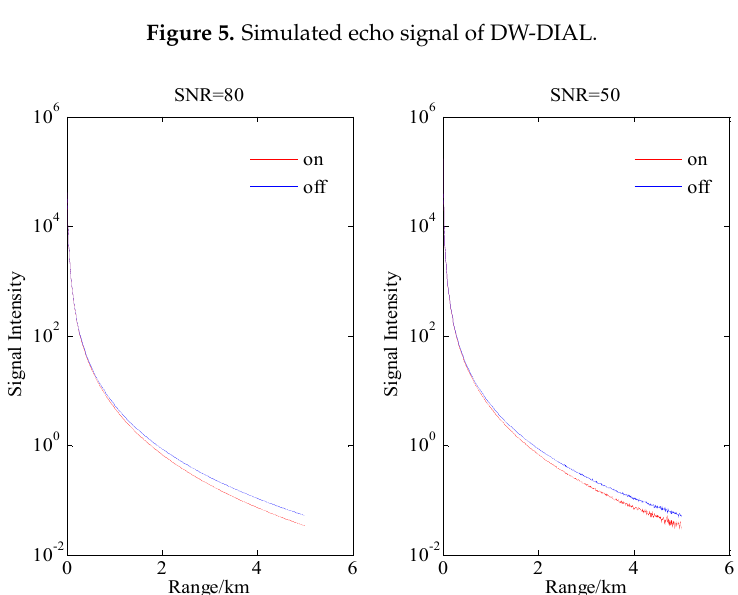
Figure 6. Simulated echo signal of DW-DIAL with signal to noise ratio (SNR) of 80 and 50.